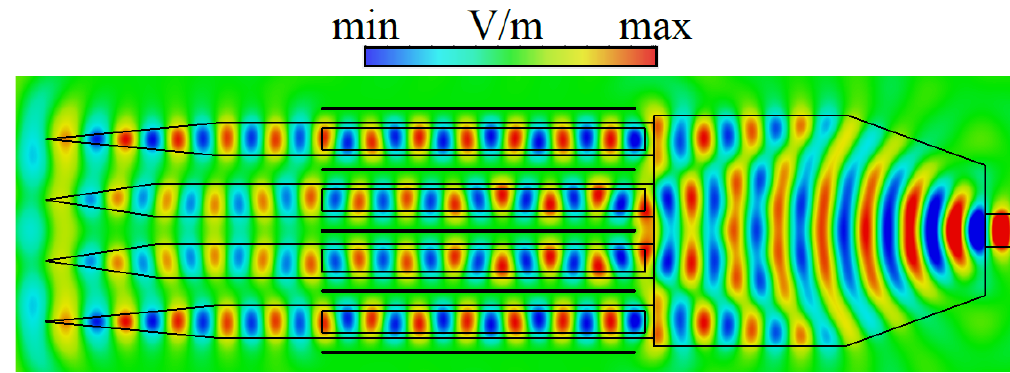
Figure 35. Field simulation of the MMI-fed antenna array at 90GHz.